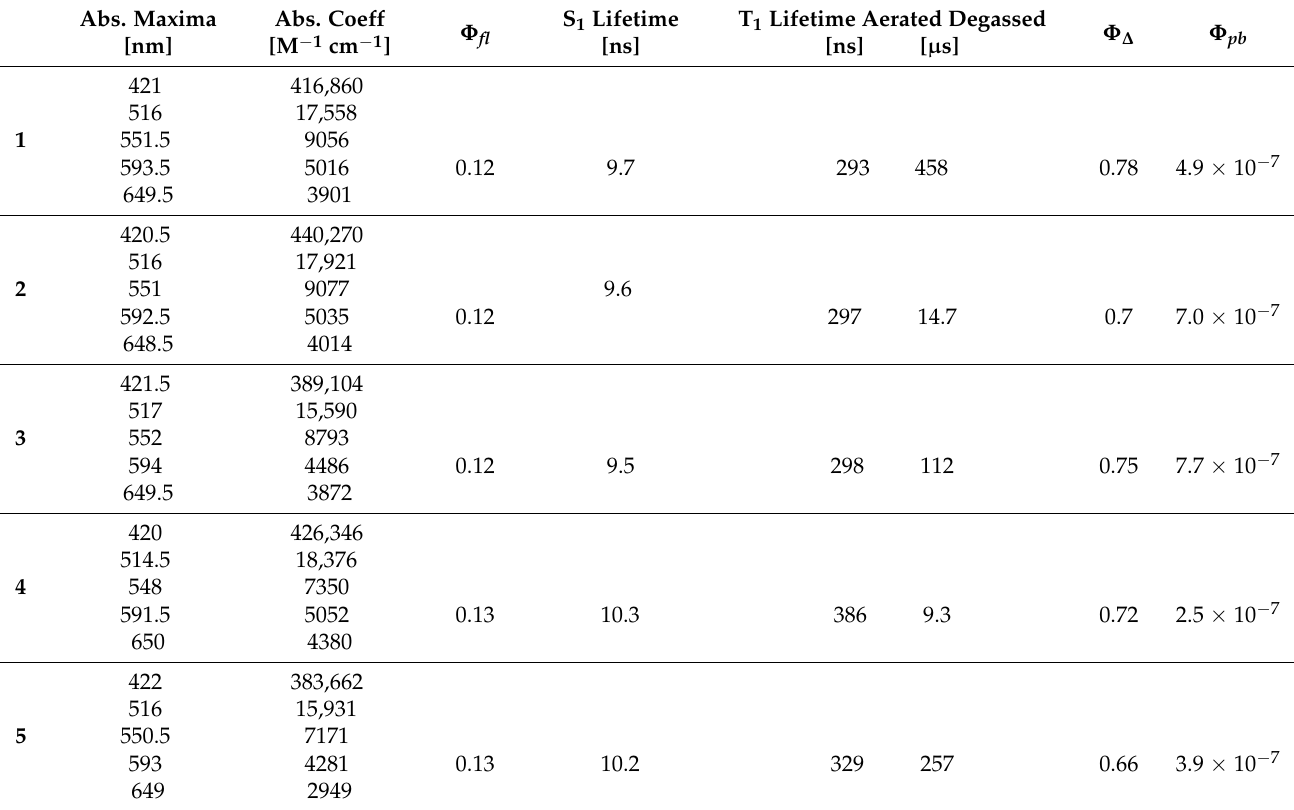
Table 1. Spectral and photophysical parameters. Toluene solutions, 293